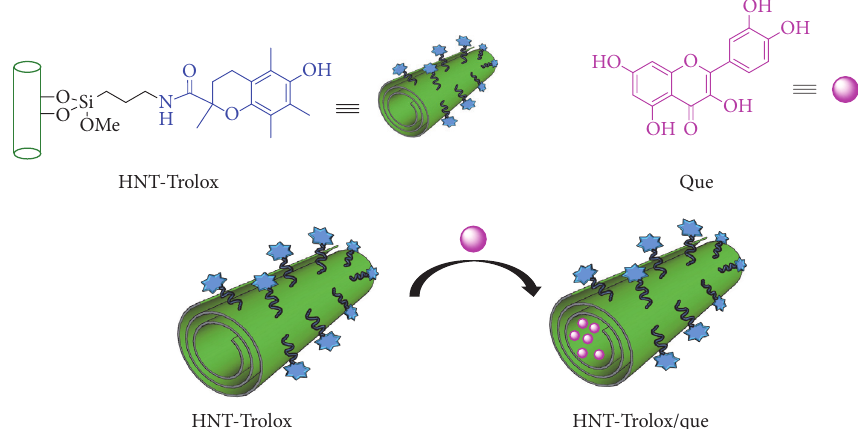
Figure 6: Schematic representation of quercetin loading into HNT-Trolox. Reproduced from [39] with permission from the Royal Society of Chemistry.